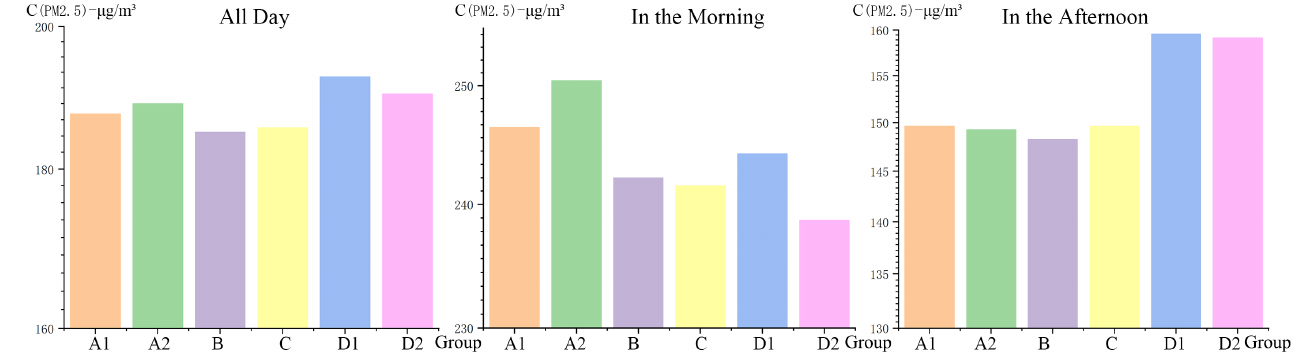
Figure 5. Comparison of PM2.5 concentrations across the six research